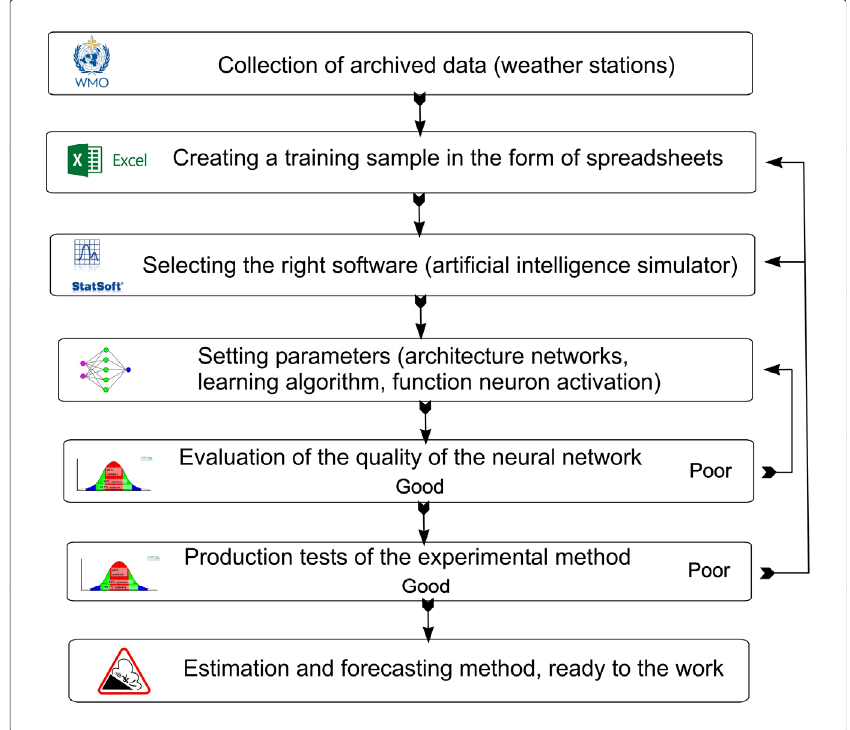
Figure 4. The stages of creating the avalanche forecasting method .